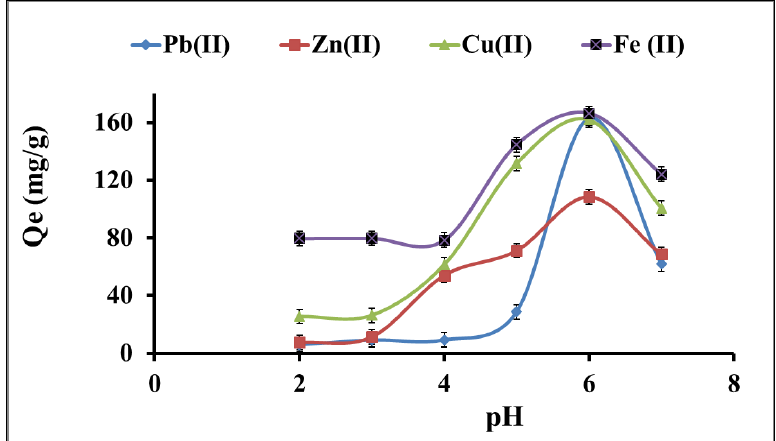
Figure 1. Effect of pH on the adsorption of Pb(II), Zn(II), Cu(II), and Fe(II) onto 0.03 g of renewable carbon from a mixed-waste source (RC-MWS) at room temperature and with a contact time of 60 min.